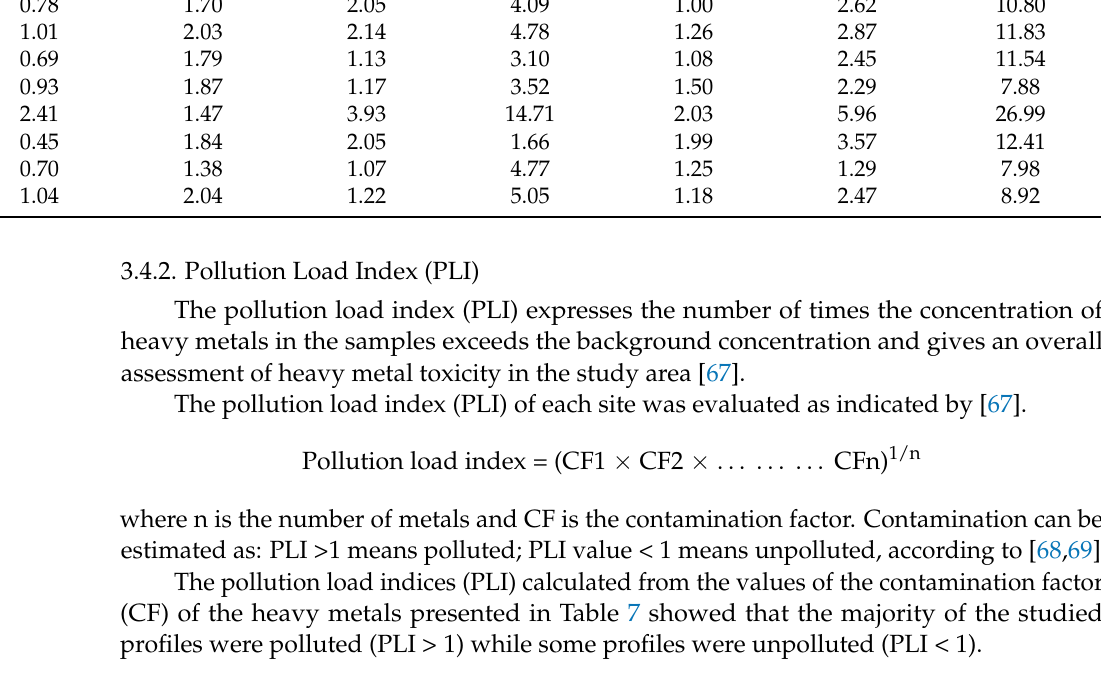
Table 7. Values of pollution load indices (PLI) and potential ecological risk indices (PER) for the measured heavy metals in the studied area.